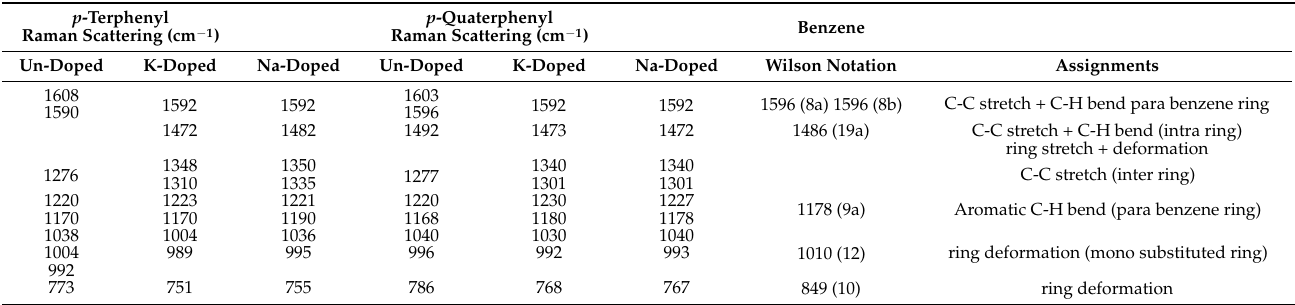
Table 2. The main observed Raman frequencies (in cm − 1 ) of p -terphenyl and p -quaterphenyl in neutral form, as well as when in the educed form by the potassium (K + ) and sodium (Na + ) ions (see also Figure S4 in the Supplementary